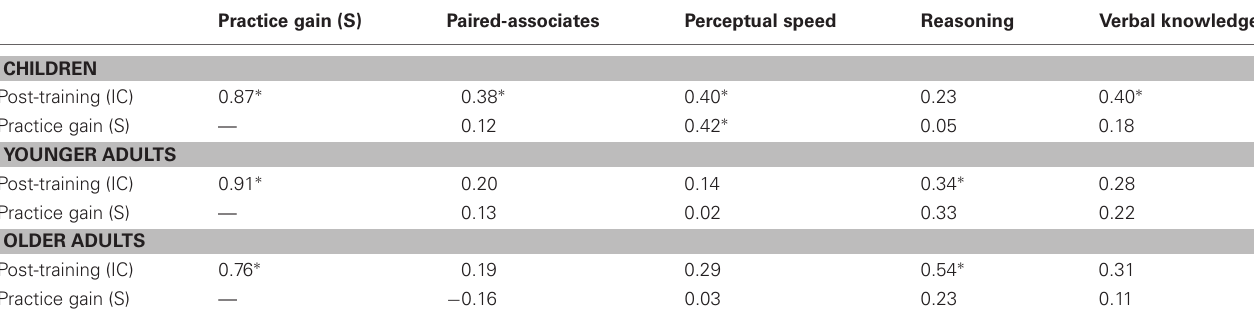
Table 4 | Correlations among cognitive composites, post-training memory performance (IC), and linear gain in memory performance from practice (S) separately for the age groups.